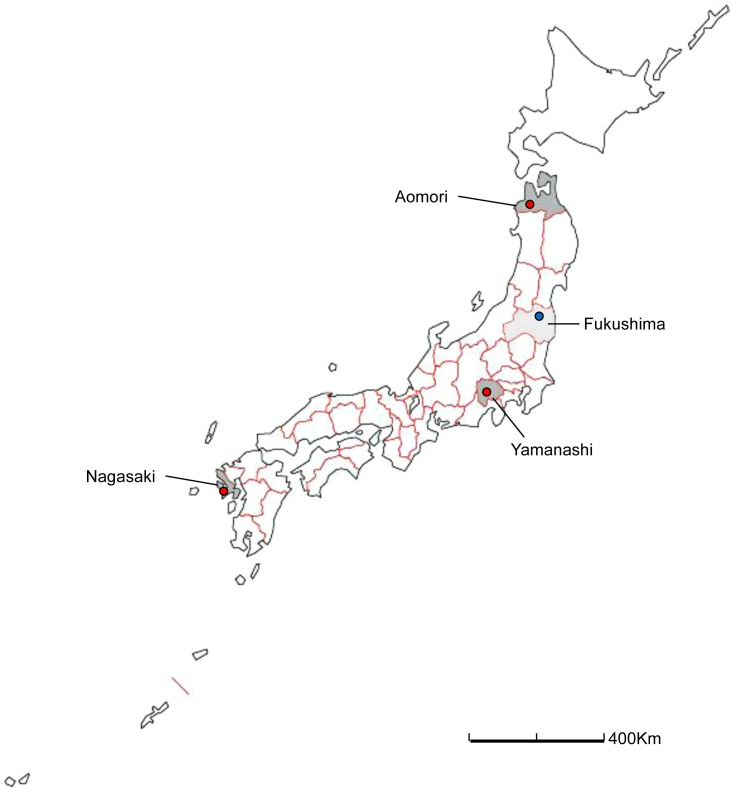
Location of Aomori Prefecture, Yamanashi Prefecture, Nagasaki Prefecture and Fukushima Prefecture.